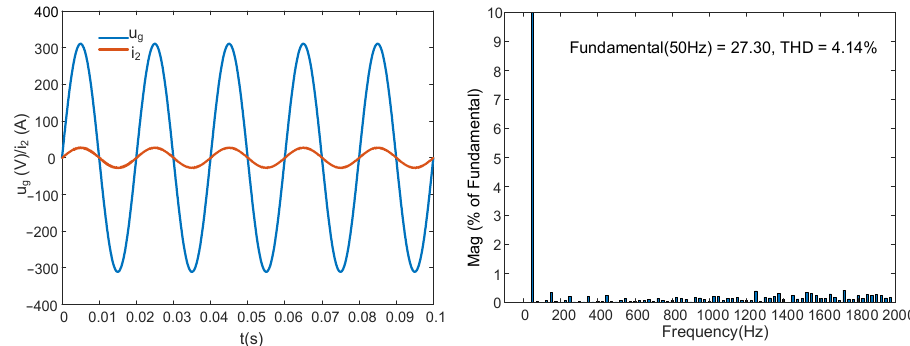
A, and the THD was 4.14%. Then, the FOPI was employed to control the grid current and the integral order λ = 0.95; the simulation results are shown in Figure 13. The RMS value of was 27.30 A, and the THD was 1.93%. 𝑖𝑖 2